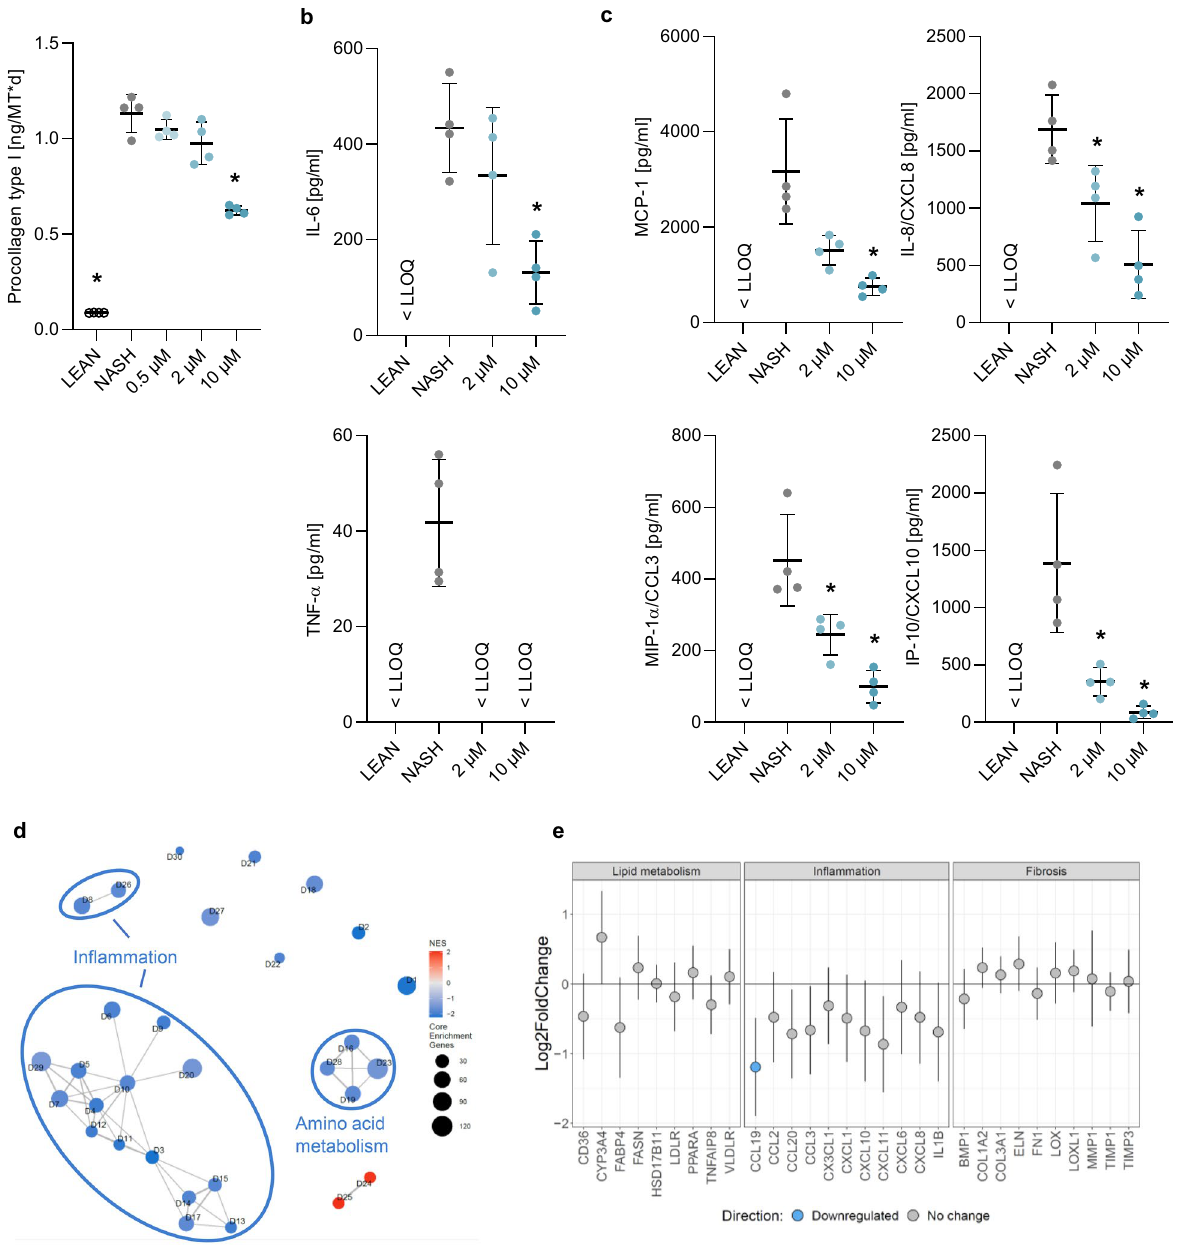
Figure 7. Selonsertib decreased the inflammation and fibrosis in NASH hLiMTs. ( a ) Selonsertib concentration- dependently decreased secretion of procollagen type I in the 3D NASH model. This reduction was significant at 10 µM (*p < 0.05). ( b , c ) Selonsertib exhibited anti-inflammatory activity, evident as a concentration- dependent decrease in the production and secretion of ( b ) pro-inflammatory cytokines, TNF-α and IL-6 and ( c ) chemokines, MCP-1, MIP-1α (CCL3), IP-10 (CXCL10) and IL-8 (CXCL8). ( d , e ) Transcriptomic profiling of Selonsertib treatment (2 µM) in 3D NASH model. ( d ) Enrichment map of gene sets derived from GSEA, comparing Selonsertib-treated NASH samples to non-treated NASH hLiMTs on day 10 of treatment. The 30 most significantly regulated gene sets are displayed. Color scale represents NES. Red nodes represent gene sets upregulated upon Selonsertib treatment, whereas blue nodes represent gene sets downregulated. The size of the nodes depicts the numbers of core enrichment genes. Nodes are grouped by their similarity, with connecting lines representing common genes between nodes. Clusters of functionally related nodes were summarized and annotated. Full gene set lists are provided in Supplementary Table S4. ( e ) Expression profile of key genes associated with lipid metabolism, inflammation and fibrosis. Plots show log2 fold change between Selonsertib- treated NASH samples compared to non-treated NASH hLiMTs on day 10 of treatment. Error bars represent 95% confidence intervals associated with log2 fold change values. Blue indicates significant downregulation and red significant upregulation in Selonsertib-treated NASH samples (FDR < 0.05). Data points are derived from single hLiMTs (n =